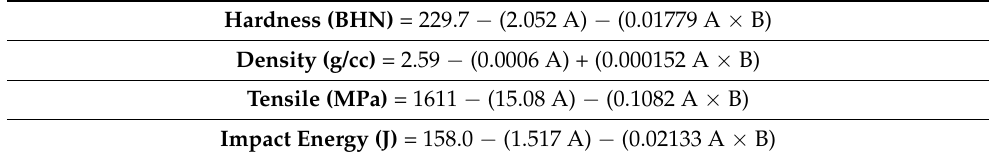
Table 2. Predictive models.